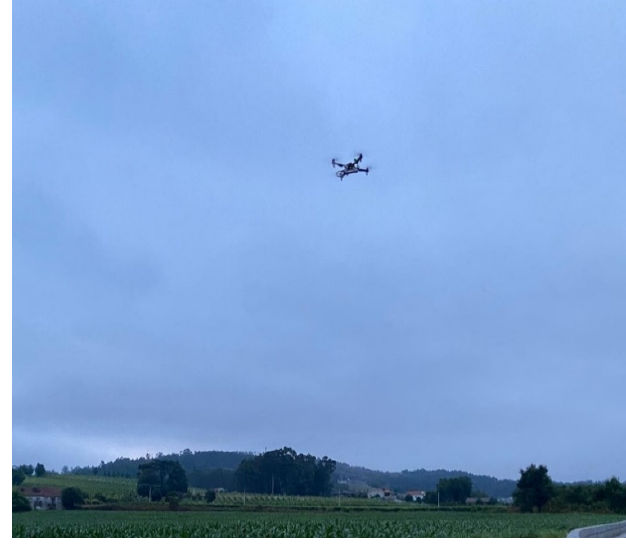
Figure 3. Multirotor used in this